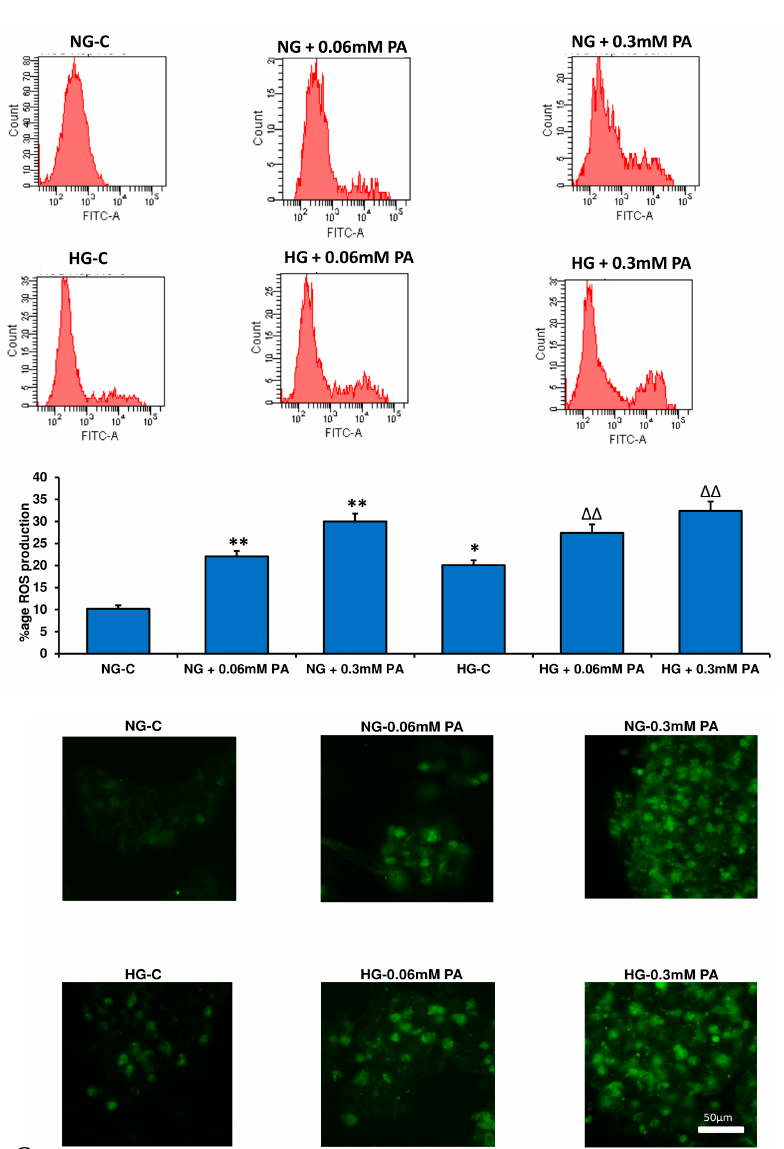
Figure 2. Effect of high glucose/high palmitic acid (HG/HPA) on reactive oxygen species (ROS) production. HepG2 cells were treated with high glucose/high palmitic acid, as described in the Materials and Methods section, and ROS were measured fluorimetrically ( A ) using the cell permeable probe 2’,7’-dichlorofluorescein diacetate (DCFDA), and by flow cytometry ( B ) using the FACSDiva software, as described previously. Production of ROS was also measured microscopically, in which cells grown on cover slips were incubated with DCFDA after high glucose/high palmitic acid treatment and fluorescence immediately visualized using an Olympus fluorescence microscope ( C ). Original magnification ×200. The results are expressed as mean +/ − SEM of three independent experiments. Asterisks indicate significant differences (* p ≤ 0.05, ** p ≤ 0.005) relative to untreated control cells under normal glucose condition (NG-C), and triangles indicate significant differences ( ΔΔ p ≤ 0.005) relative to untreated control cells under high glucose condition (HG-C).